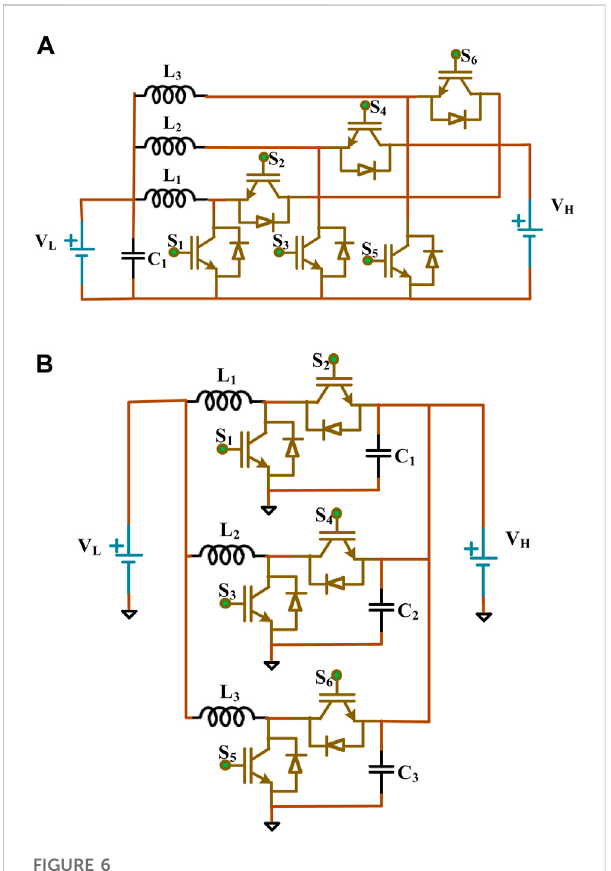
FIGURE 6 Non-isolated multiphase converters (A) interleaved boost (B) sixteen phase.